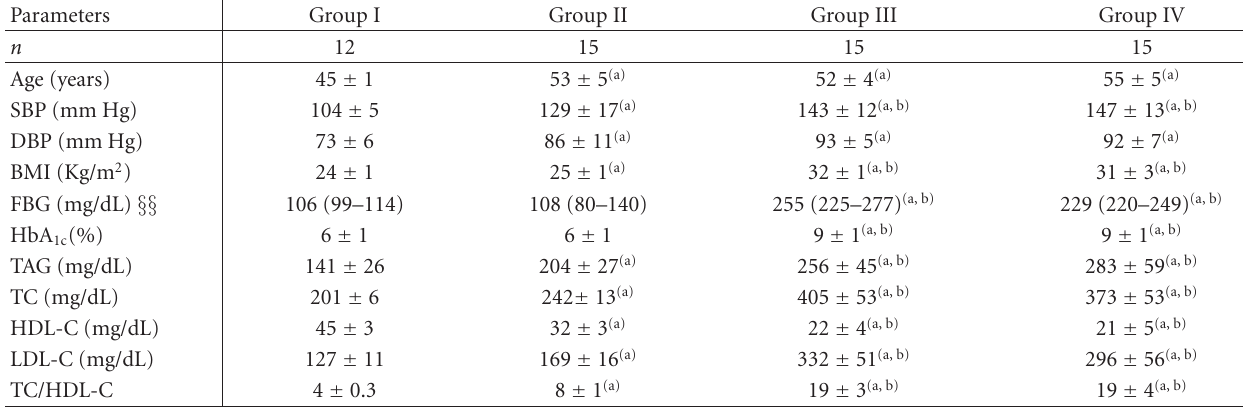
Table 1: Clinical and laboratory characteristics of the studied groups; healthy controls (group I), ischemic heart disease (group II), type 2 DM who did not perform CABG (group III), and type 2 DM who performed CABG (group IV). Data are mean ± SD. n = number of